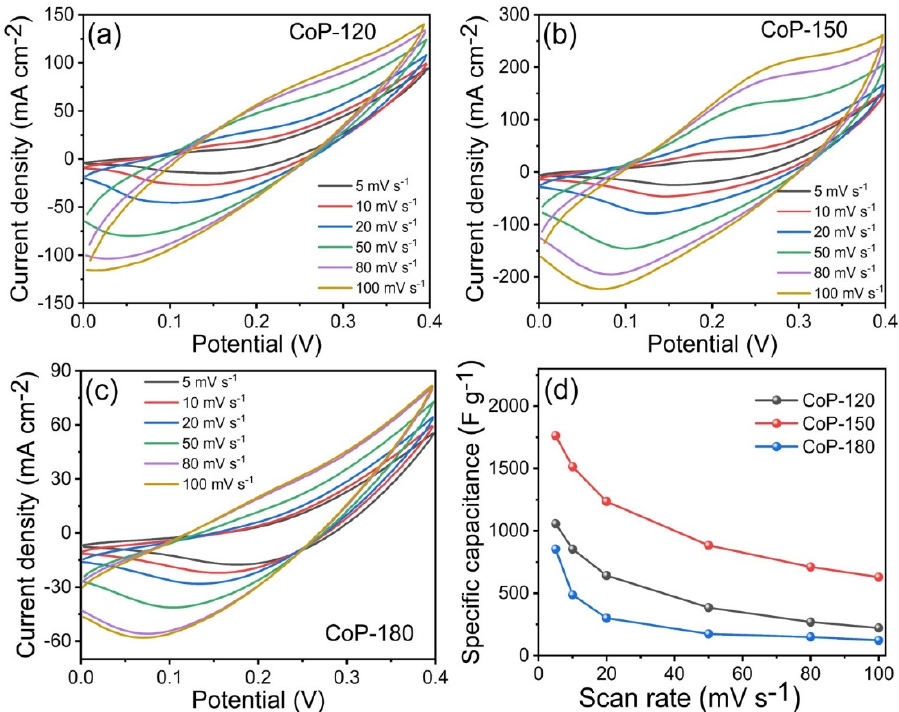
Figure 5. ( a – c ) CV measurements of the CoP-120, CoP-150, and CoP-180 electrodes at various scan rates in the range of 5–100 mV s − 1 , ( d ) specific capacitance of the CoP-120, CoP-150, and CoP-180 electrodes at various scan rates, respectively.